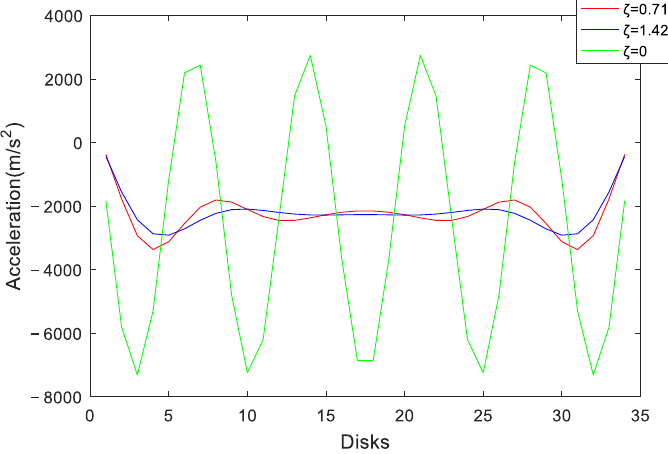
Figure 9. Acceleration of each disk under different damping ratios.